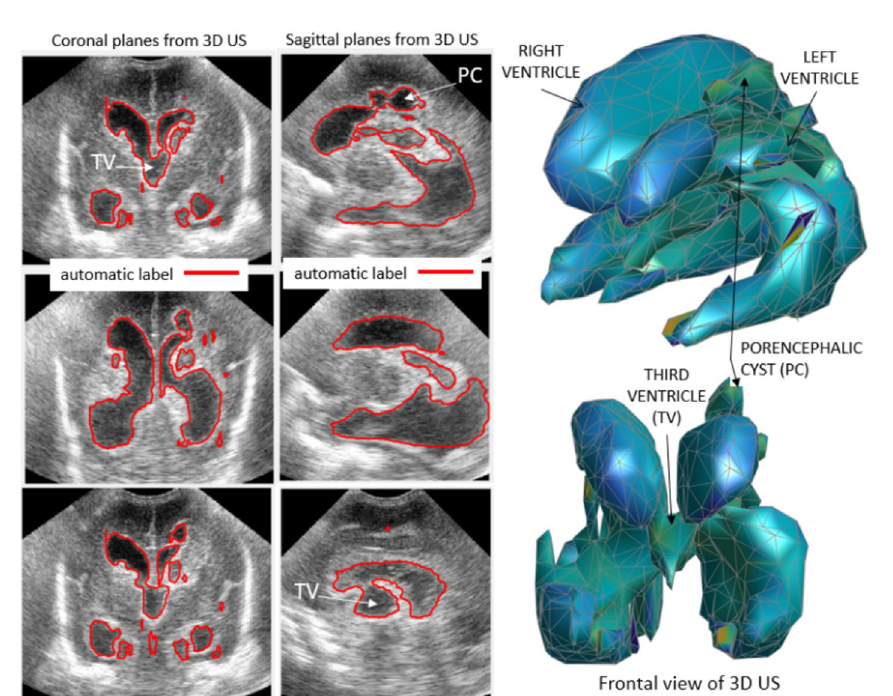
Figure 7. Representative coronal and sagittal planes extracted from a 3D US from a patient with PHVD after grade III GMH-IVH and right intraparenchymal haemorrhage. The contours of the ventricular system measured automatically are drawn in